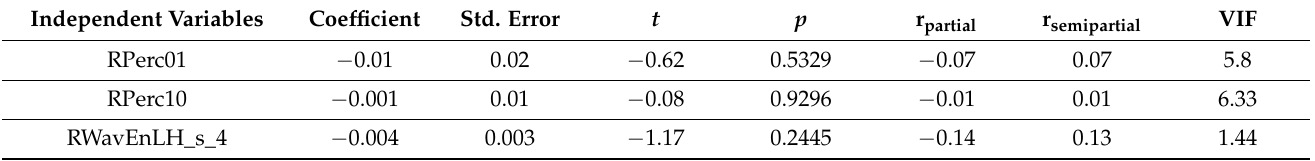
Table 6. Multivariate analysis of the parameters independently associated with the PR+ status.